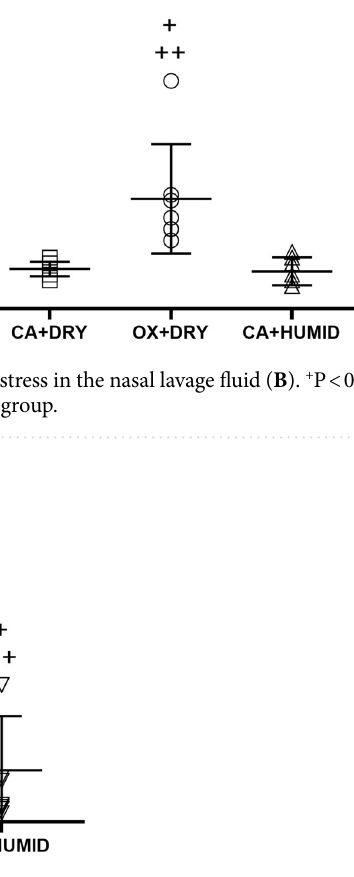
Figure 6. Saccharine transit time test (minutes). *P < 0.05 compared to CA + DRY and CA + HUMID groups. + P < 0.05 compared to CA + DRY group. ++ P < 0.05 compared to CA + HUMID